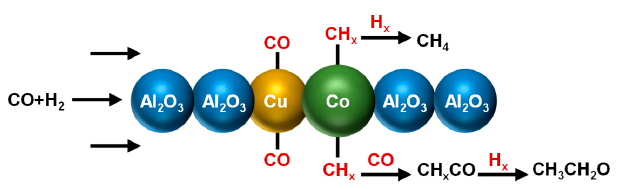
Figure 11. The reaction scheme of CO hydrogenation to ethanol over synergetic catalysis of uniformly dispersed bimetallic CuCo